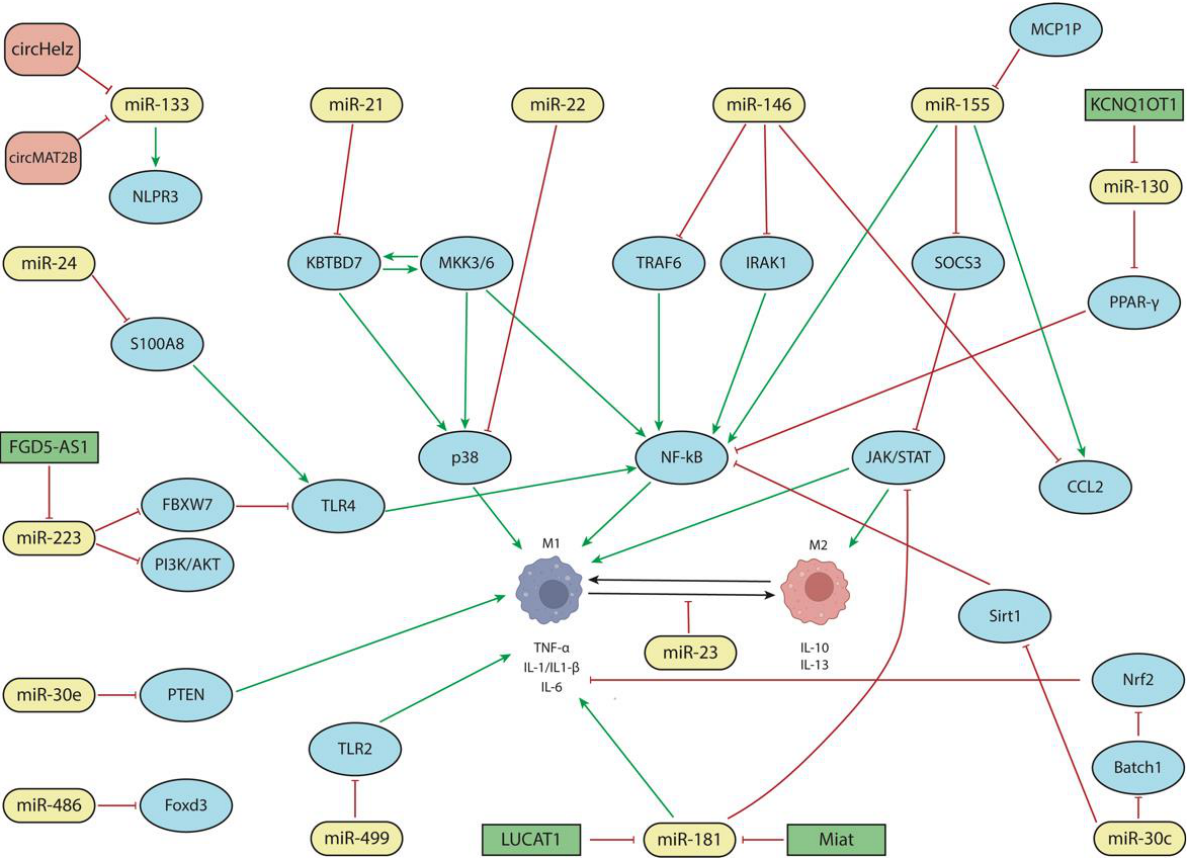
Figure 1. Cardiac inflammation. Schematic representation of the main miRNA, lncRNA, and circRNA gene-regulatory networks reported to play a role in distinct signaling pathways leading to cardiac inflammation. Green arrows delineate the ncRNAs that activate the signaling pathway while those depicted in red inhibit such signaling pathways. Note that many ncRNAs preferentially modulate NF-κB signaling, thus influencing M1 to M2 macrophage activation. circRNAs are depicted in green, microRNAs are depicted in yellow, and the different signaling pathways modulating the inflammatory response are depicted in blue.